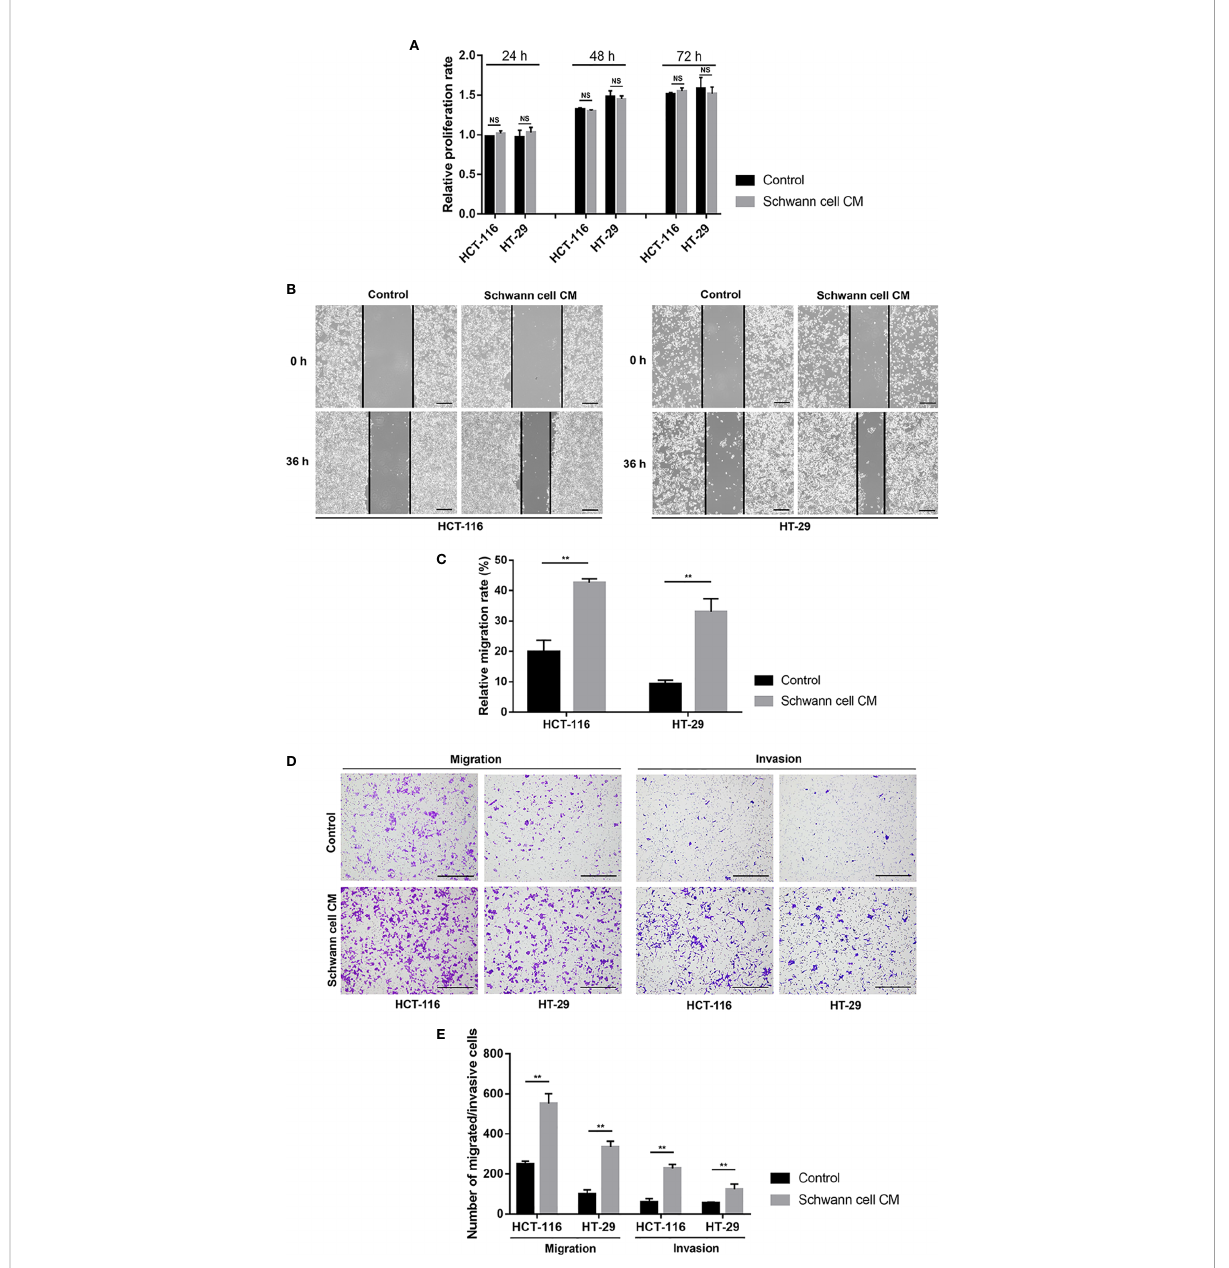
FIGURE 1 SCs promote the migration and invasion but not proliferation of CRC cells in vitro . (A) The fi ndings of the cell counting kit-8 showed that SCs had no appreciable impact on the proliferation statuses of HCT-116 and HT-29 cells. (B, C) Wound healing (scale bar, 400 µm) suggested that SCs enhanced the migration of HCT-116 and HT-29 cells. (D, E) Transwell and Matrigel assays (scale bar, 400 µm) showed that SCs enhanced the migration and invasion of HCT-116 and HT-29 cells. **P<0.01. CRC, colorectal cancer; NS, not signi fi cant; SC, Schwann